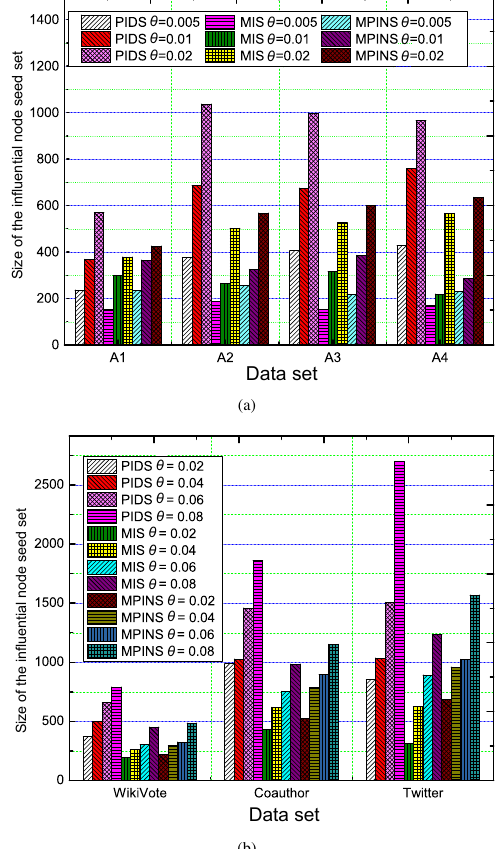
Fig. 11 Probability distribution of (a) Amazon co-purchase data sets and (b) WikiVote, Coauthor, and Twitter data sets.